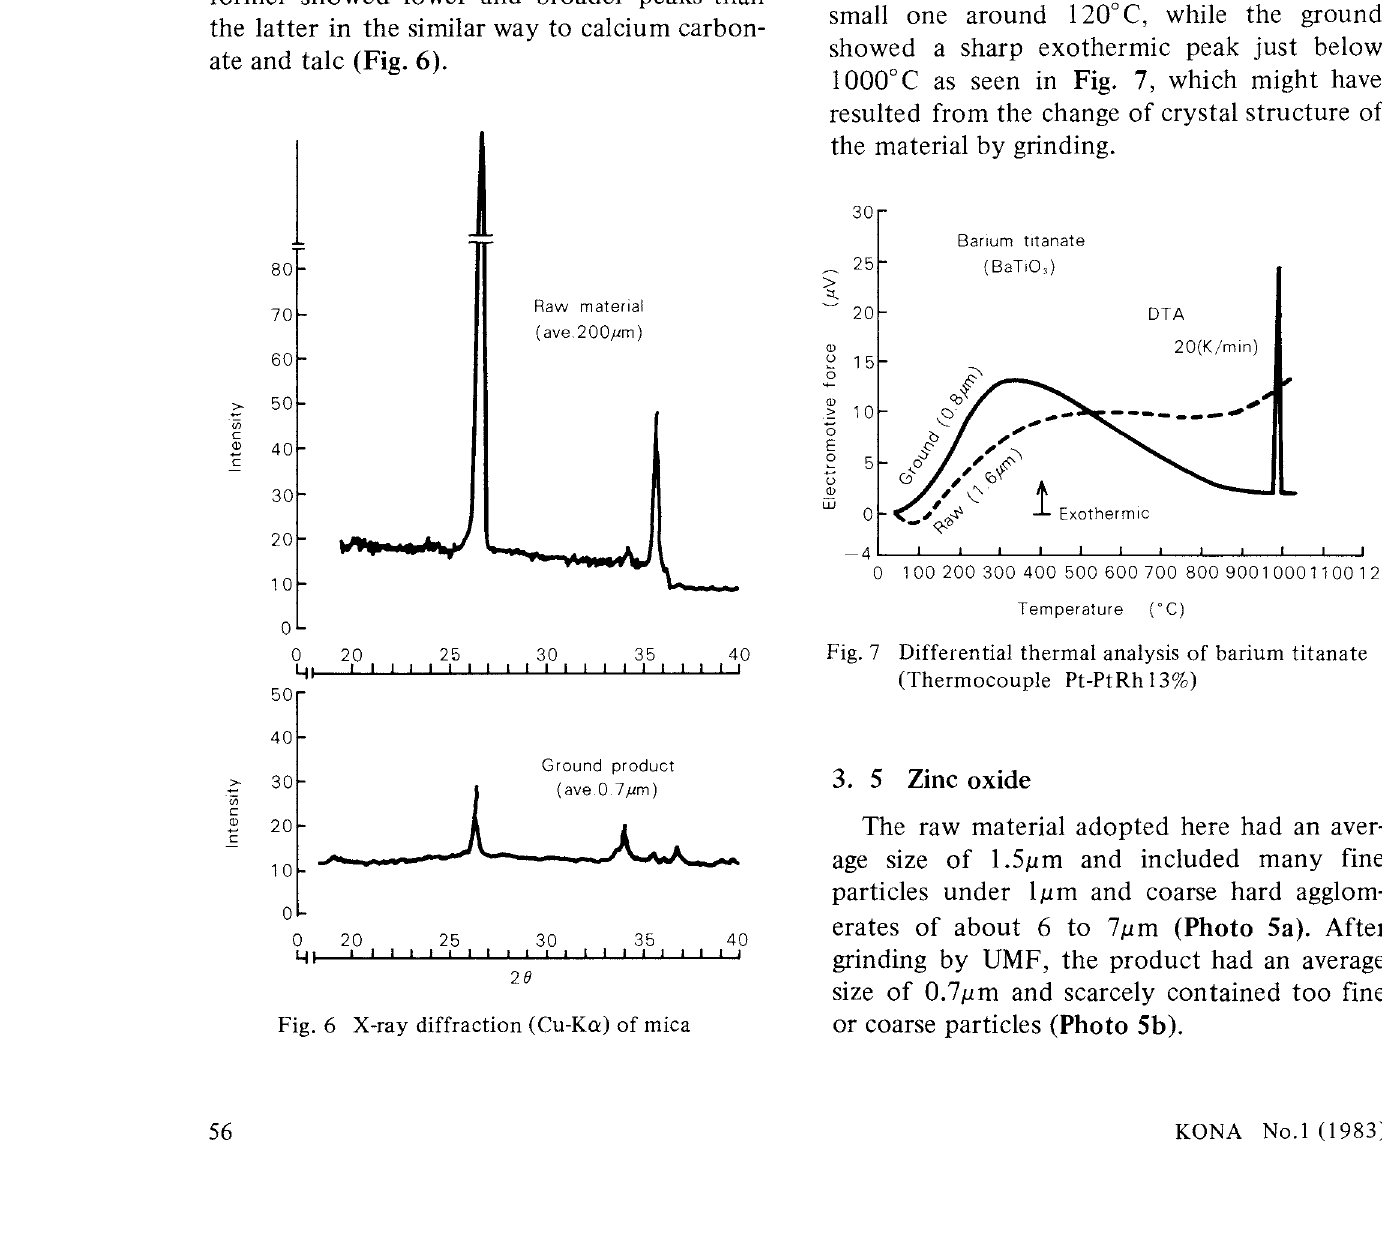
Fig. 7 Differential thermal analysis of barium titanate (Thermocouple Pt-PtRh